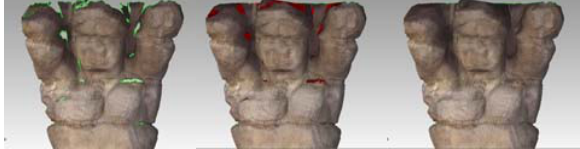
Figure 9. Fill hole functions for the upper part of the